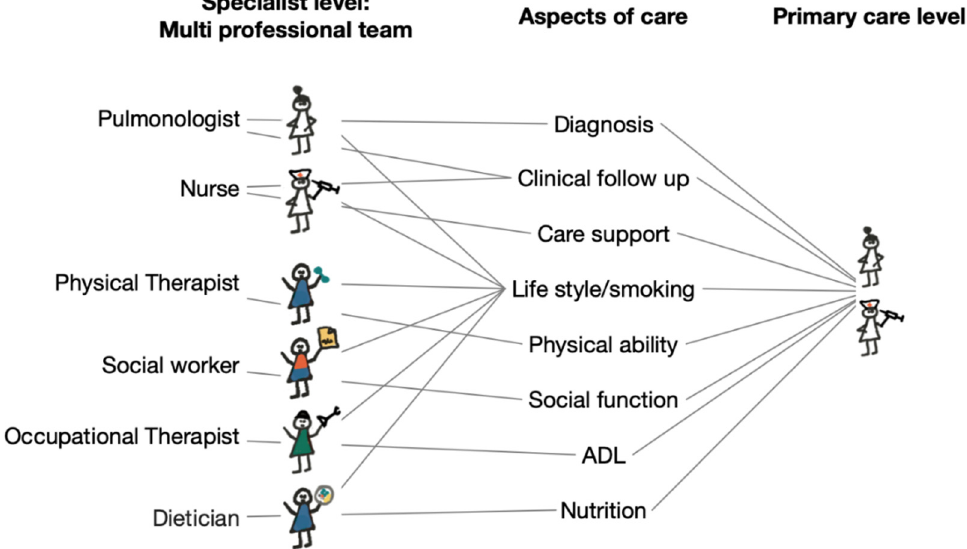
Figure 1. The multi-professional team provides a highly specialized analysis and treatment recommendations for different domains of patient needs. The knowledge pertaining to the patient must not be lost when the patient transfers to primary care where, most often, the care process is confined to the GP and the nurse. Also, the multi-professional team should have tools for a rational sharing of knowledge to motivate the costly model for care